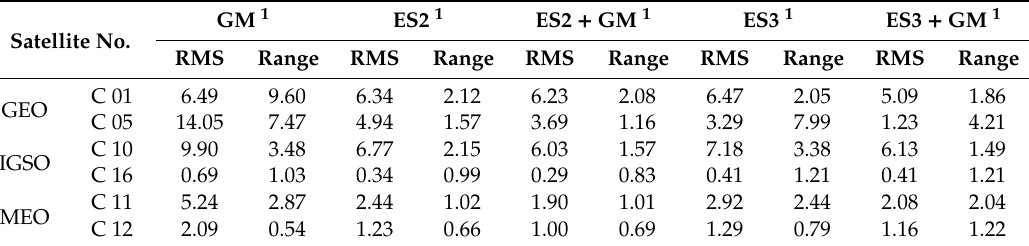
Figure 13. Change of average accuracy (RMS), stability (Range), and improvement rate of 24 h forecast using different models: ( a ) is the changes of RMS and Range, and ( b ) is the changes of improvement percentage of RMS and Range. Table 2. Statistics of the different models for 6 h prediction (ns).